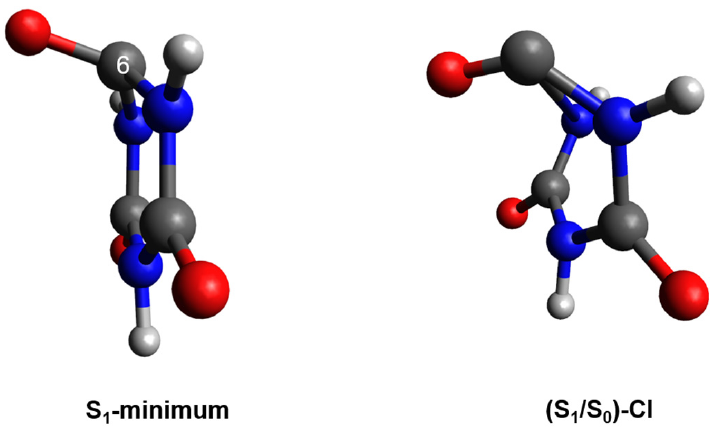
Figure 5. Optimized S 1 minimum-geometry and the (S 1 /S 0 ) CI found using SF-TD-DFT along the C6-puckering coordinate obtained for CA at the TD-X3LYP/C-PCM/cc-pVDZ in water.